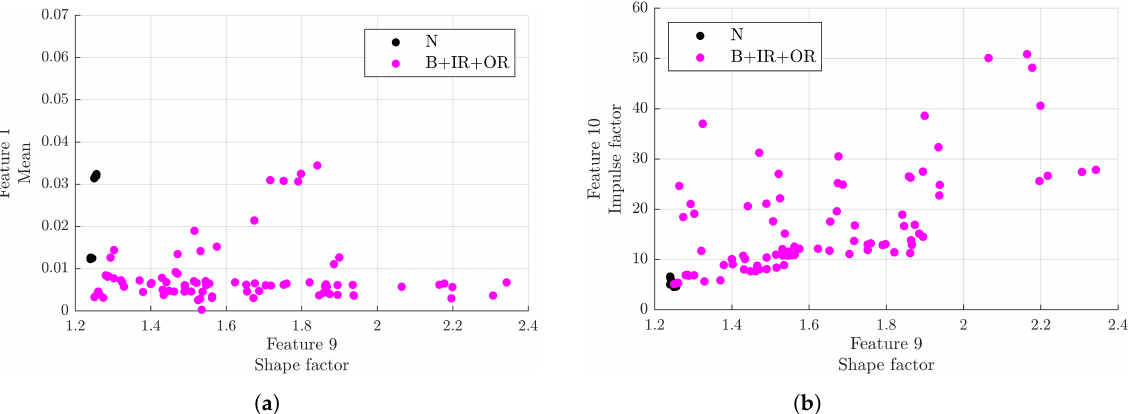
Figure 16. Distribution of signals with respect to the time domain features selected by the Fisher– Pareto algorithm: ( a ) plane formed by the first (shape factor) and second (mean) selected features; ( b ) plane formed by the first (shape factor) and third (impulse factor) selected features.